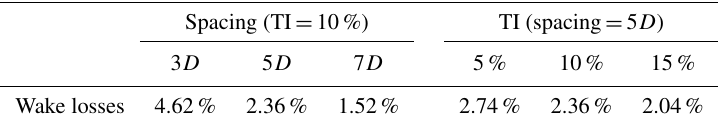
Table 2. Total baseline wake losses compared to free-stream operation for a two-turbine array with different turbine spacings and turbulence intensity values, assuming uniformly distributed wind